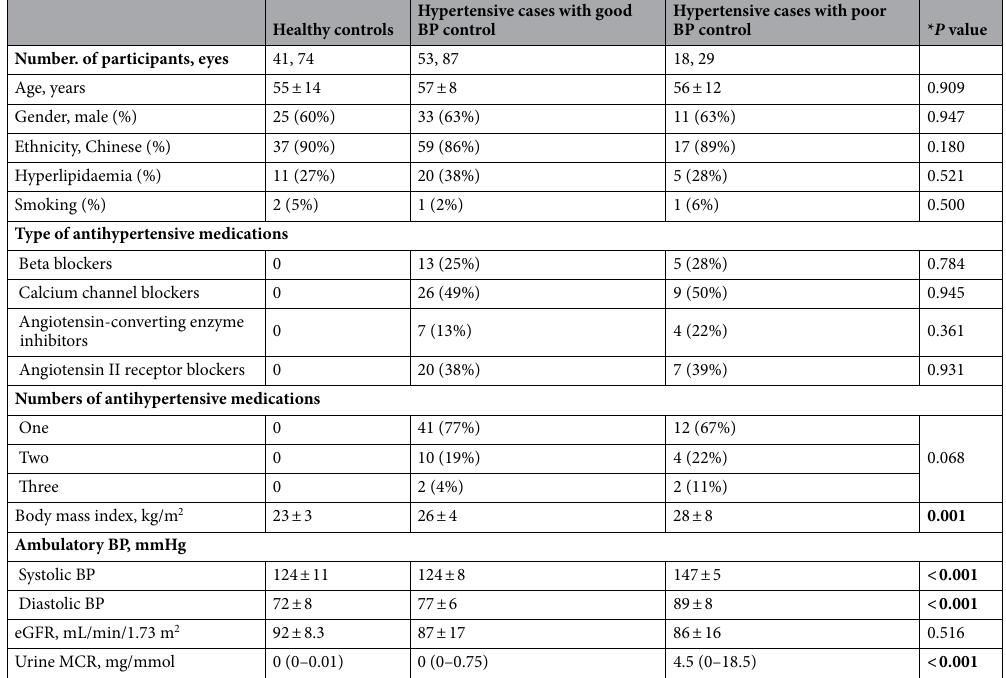
Table 1. Clinical characteristics of participants, stratified by hypertension status and blood pressure control. SD standard deviation, BP blood pressure, eGFR estimated glomerular filtration rate, MCR microalbumin- to-creatinine ratio. Data are number (%) or mean ± SD or median (interquartile range), as appropriate. Bold face indicates statistically significant P value. *Test for differences between groups, based on one-way analysis of variance (ANOVA) for normally distributed continuous variables or kwallis for non-normally distributed continuous variables and with chi-square tests or Fisher’s exact test for categorical